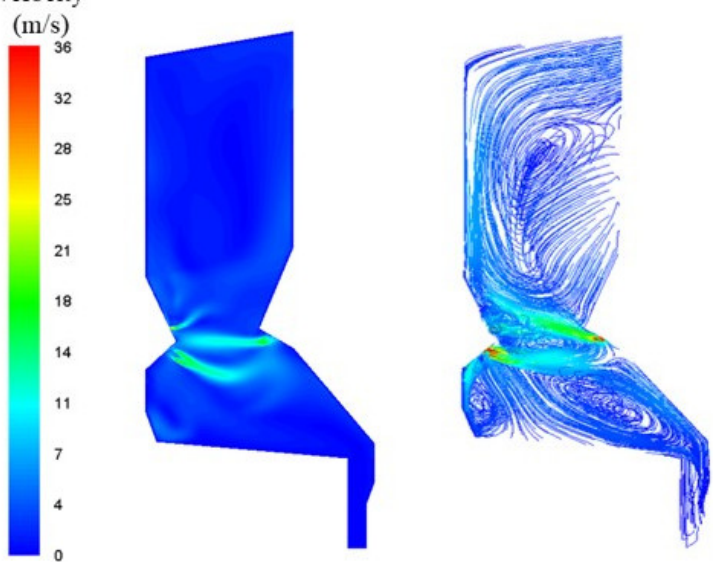
Table 3. Air distribution condition of boiler cold flow field.